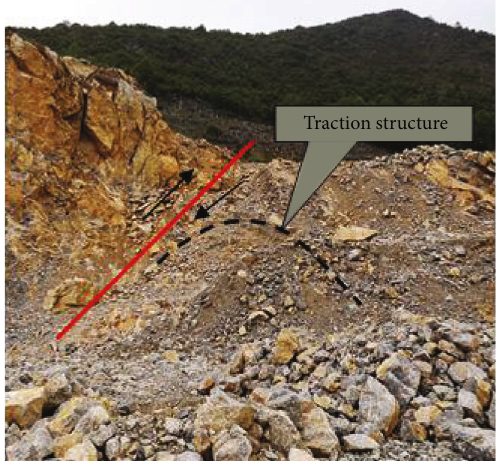
Figure 3: F1 fault crossing the